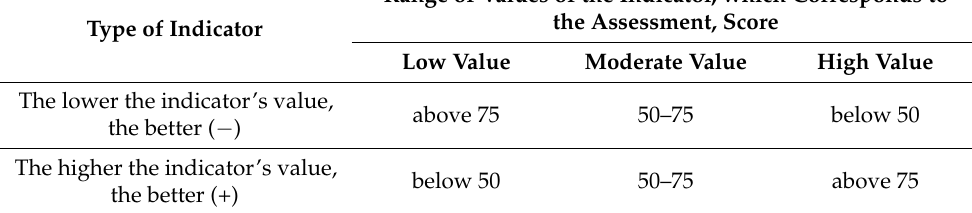
Table 2. Matrix for specifying the level of risk of smart cities on a scale from one to five. Value of the Indicator That Characterises the Risk Significance of Risk High Value Moderate Value